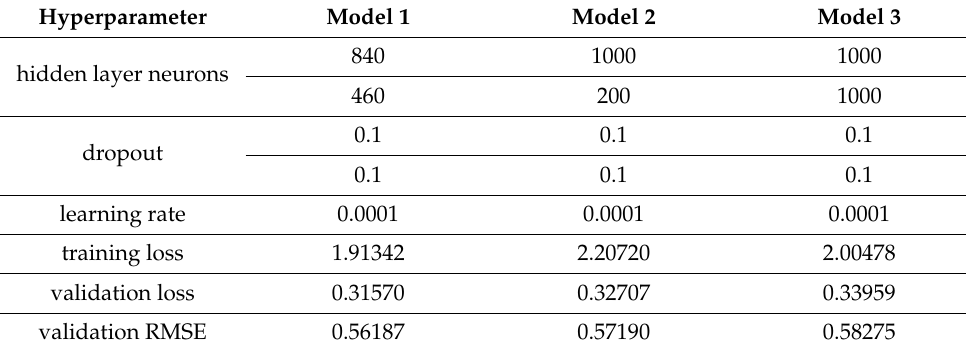
Table 2. Model hyperparameter settings and training results.